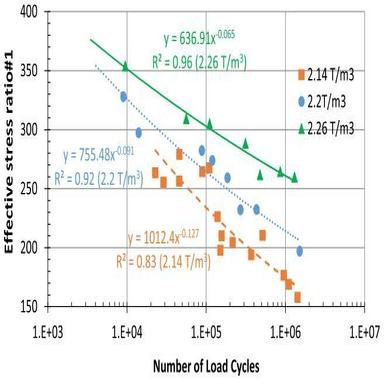
Effect of density on FBS flexural fatigue life (3% bitumen 2% lime FBS beam samples).